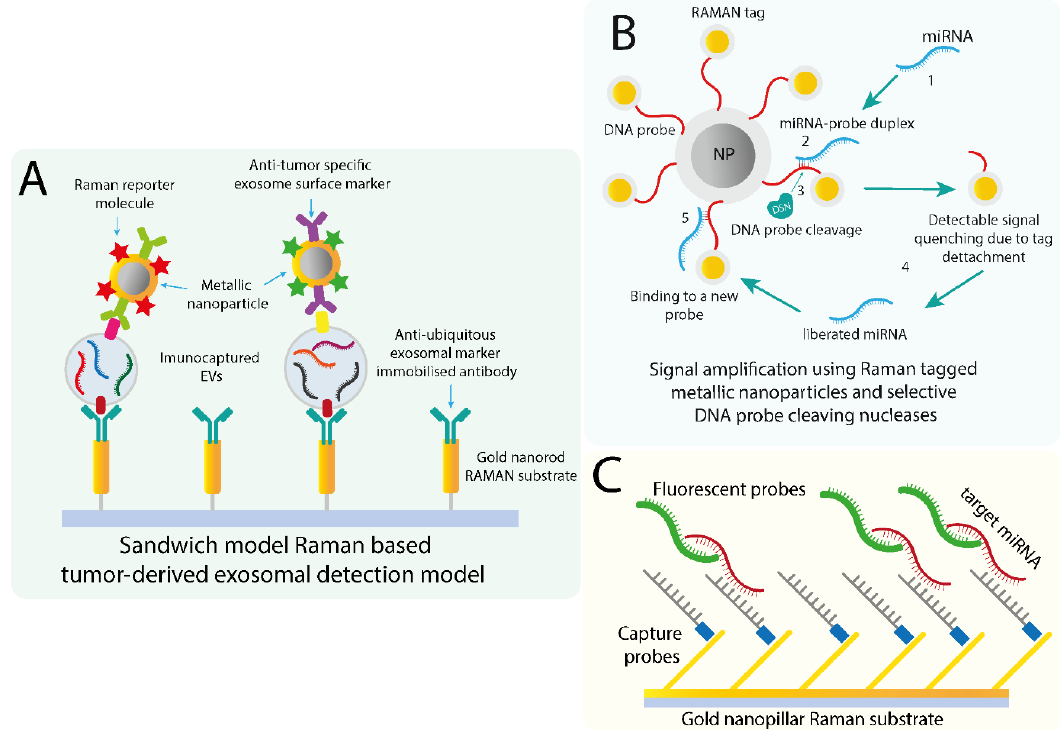
Figure 3. Overview of several SERS-based exosomes ( A ) and miRNA detection and quantification methods utilizing both metallic nanoparticle ( B ) and immobilized ( C ) Raman substrates. The